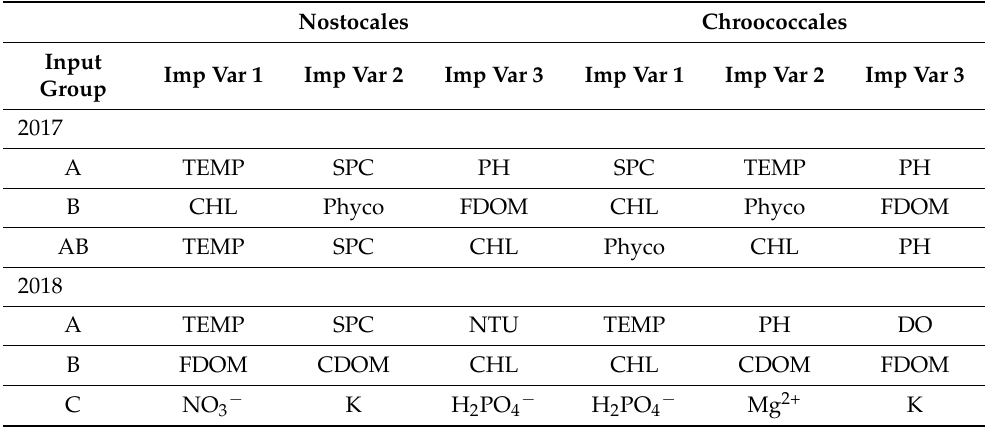
Table 5. Most influential predictors for cyanobacteria orders Nostocales and Chroococcales, in Pond 1 as determined using the random forest